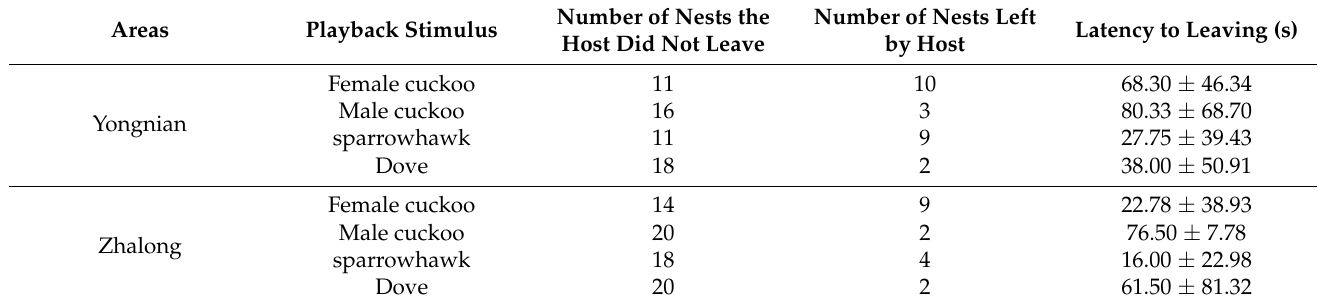
Table 1. Response of oriental reed warbler to different playback stimuli in two areas. Areas